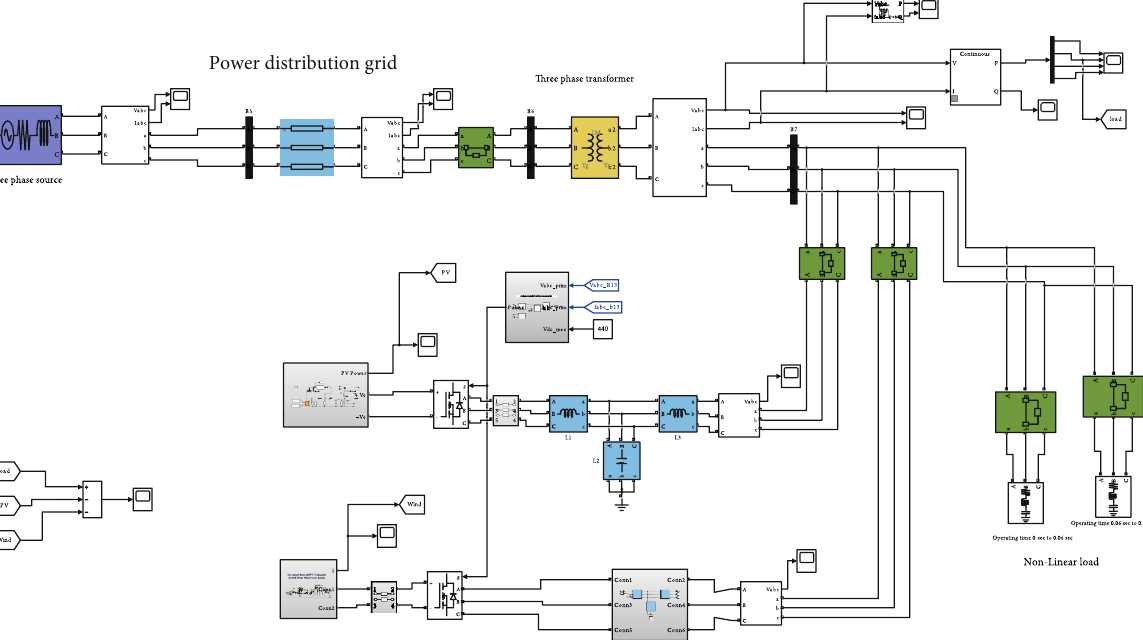
Figure 21: Proposed simulation model of the DNN controller-based microgrid integrated with a hybrid PV/wind energy system.